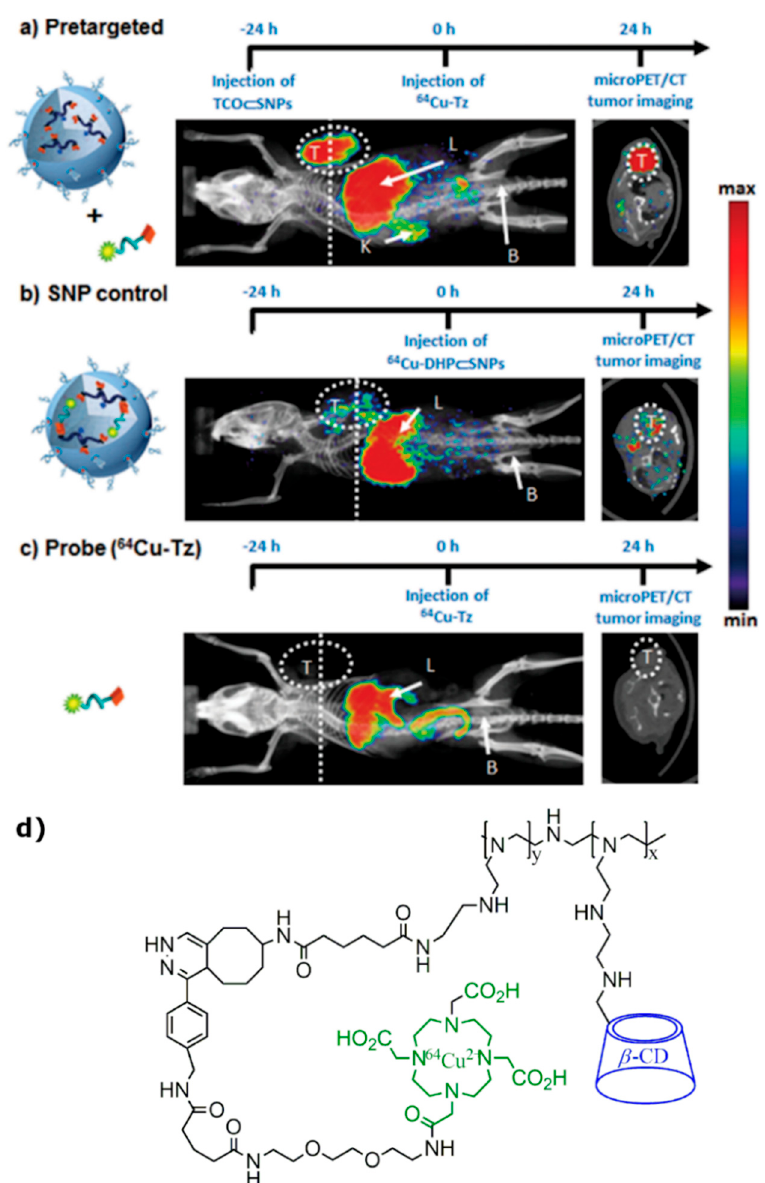
Figure 10. Timeline of the injection protocol employed for ( a ) pre-targeted, ( b ) SNP control (64Cu-DHP ⊂ SNPs), and ( c ) free radiolabeled reporter (64Cu-Tz) studies. Representative in vivo microPET / CT images of the mice (n = 4 / group) subjected to the three studies at 24 h p.i. Labels T, L, K, and B refer to the tumor, liver, kidney, and bladder, respectively. Dashed lines correspond to the transverse cross-section through the center of each tumor mass, whose image is shown in the right panel [99]. The images are reprinted with permission from publisher [99]. ( d ) The chemical structure of the tumor targeting imaging probe developed by Hou et al.